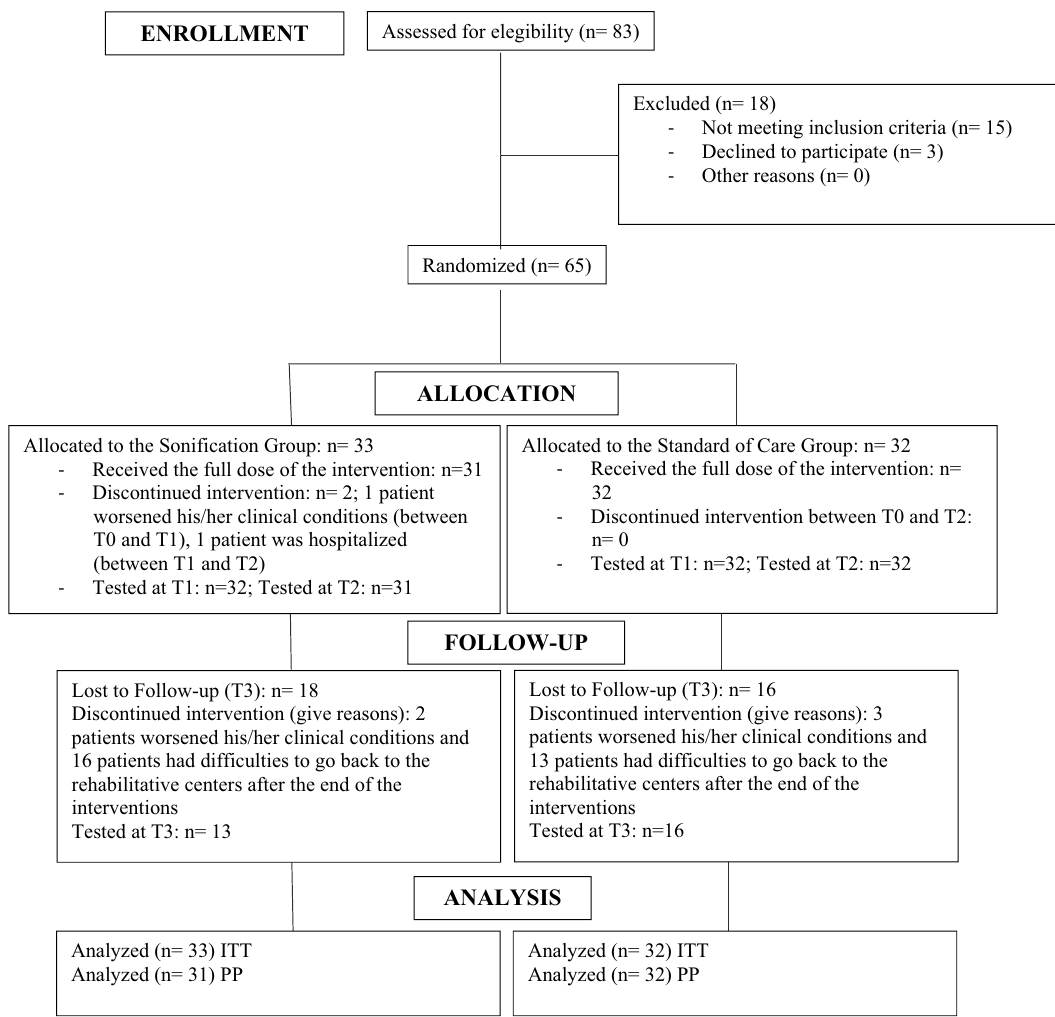
Figure 1. The flow chart of the study. All randomized patients received the allocated intervention. Between baseline and the 4-week evaluation two patients in the Sonification group discontinued the treatment. No discontinuation occurred in the Standard Care Group. After 1 month from the beginning of treatment (T3 follow-up) 18 and 16 patients were lost to follow-up in the Sonification and Standard Care Groups, respectively. The primary analysis (T2, end of the 4-week treatment) was performed on the Intention To Treat (ITT) and Per Protocol (PP) populations, with the numbers reported in the